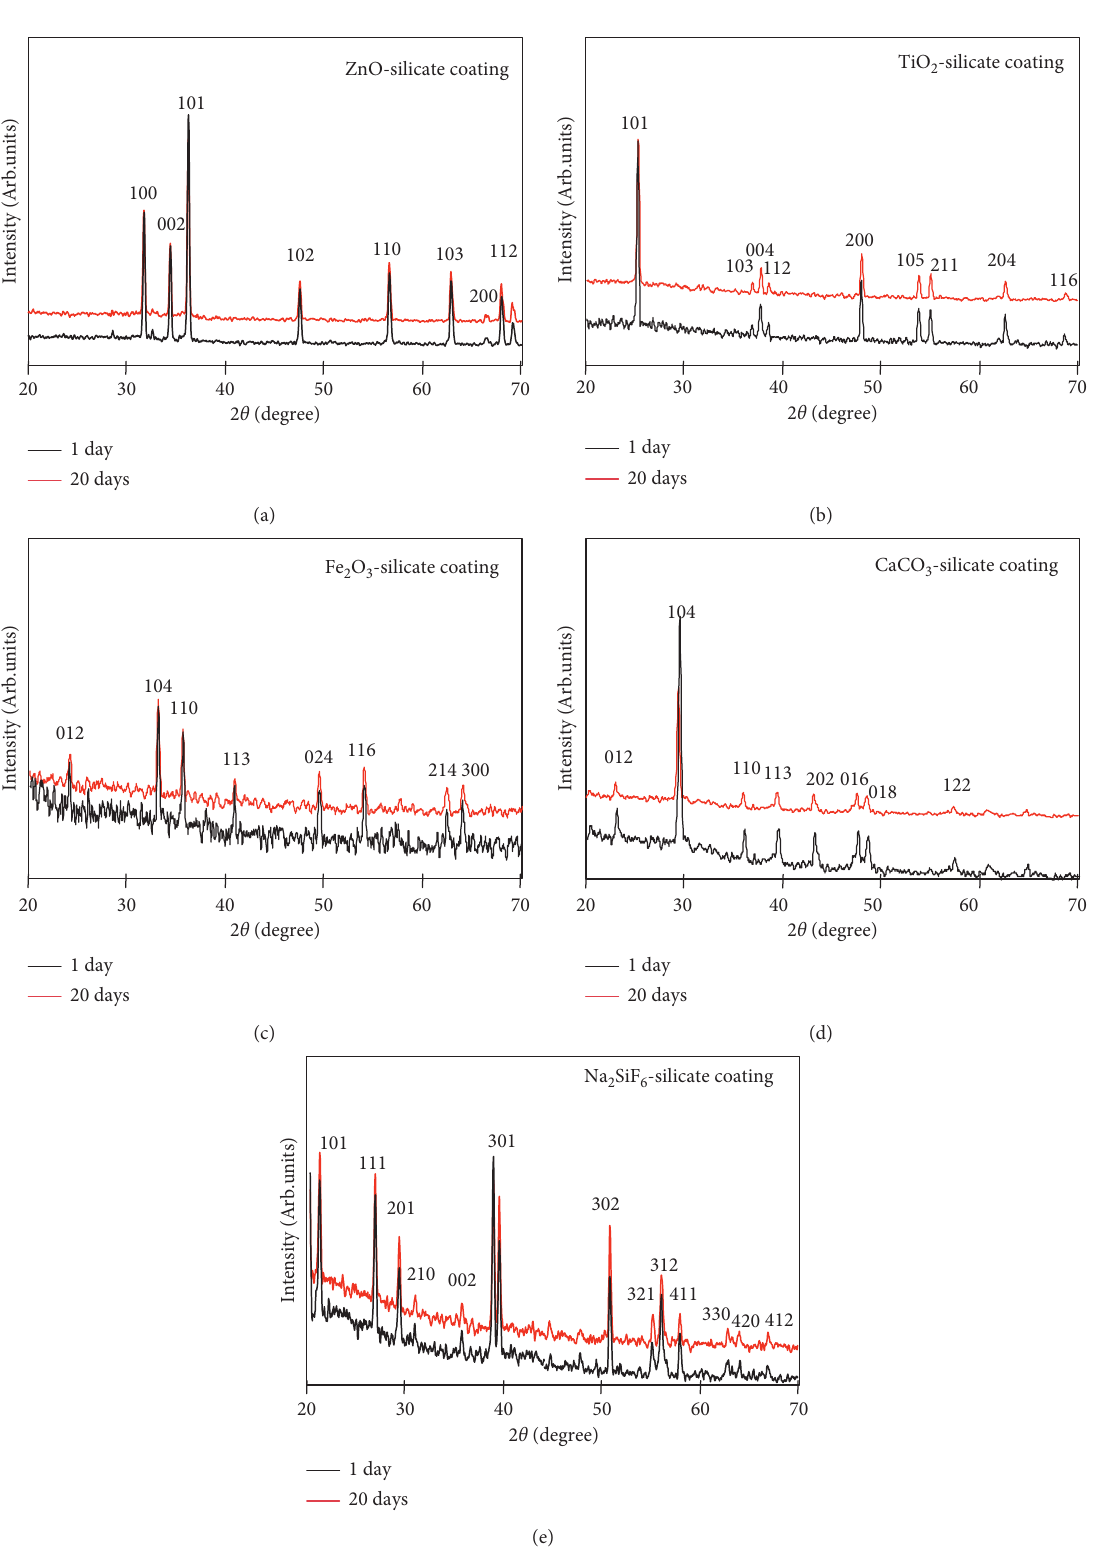
2 -silicate (b), Fe 2 O 3 -silicate (c), CaCO 3 -silicate (d), and Na 2 SiF 6 -